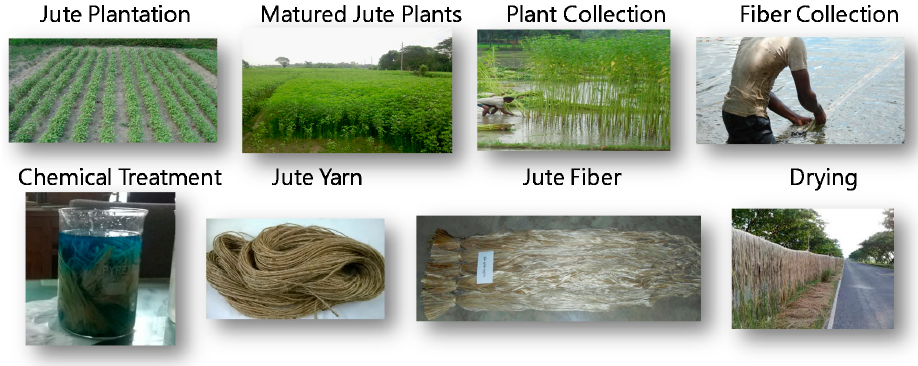
Figure 1. Producing jute fiber/yarn.